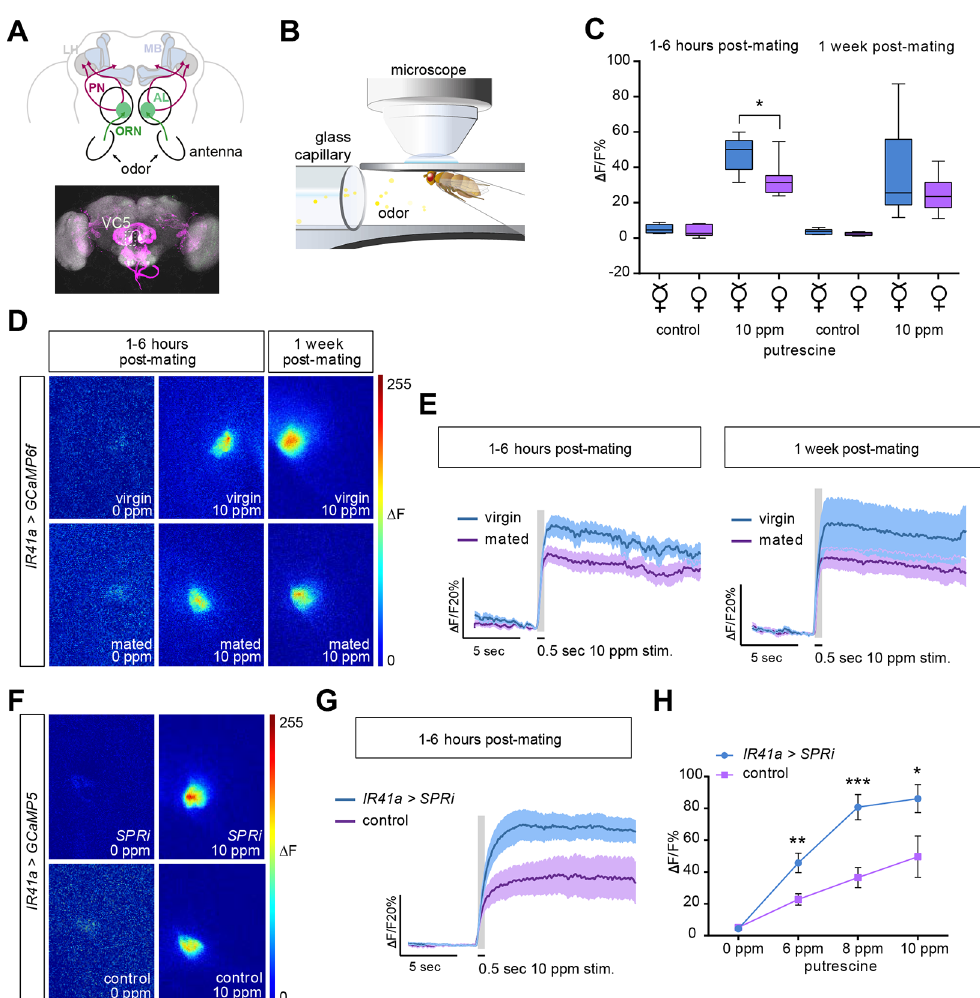
Fig 4. SPR decreases sensitivity of olfactory neurons to polyamines after mating. (A) Schematic diagram of a fly brain and its antennal appendages with olfactory sensory neurons (OSNs). OSNs project into the antennal lobe (AL), where they innervate a specific glomerulus (green). Projection neurons (PN) send the information mainly to two higher brain centers, the mushroom body (MB) and the lateral horn (LH) (top). Illustrative confocal image stack showing the IR41a and IR76b OSN innervation in the AL (bottom). VC5 is the glomerulus innervated by the polyamine-responding IR41a/IR76b sensory neurons. (B) Illustration of the in vivo calcium imaging setup. (C – E) In vivo calcium imaging of IR41-Gal4;UAS-GCaMP6f flies stimulated with water and 10 ppm putrescine, respectively. Mated females ’ OSN axon terminals show a significant reduction in their sensitivity to putrescine at 1 – 6 h post-mating. (C) Quantification of peak Δ F responses (in % Δ F/F) in virgin and mated females. Boxes show median and upper/lower quartiles, and whiskers show minimum/maximum values. * p < 0.05, unpaired t test ( n = 8). (D) Representative pseudo-color images showing the response to water and 10 ppm putrescine in virgin and mated flies at 1 – 6 h and 1 wk post-mating. (E) Average response trace (in % Δ F/F) of the VC5 glomerulus peak response at 1 – 6 h and 1 wk post-mating compared to traces from virgin females. The dark colored line in the middle presents the average value and the light shade presents the SEM. (F – H) In vivo calcium imaging of test ( IR41a-Gal4 , UAS-SPRi;UAS-GCaMP5 ) and control ( IR41a-Gal4;UAS-GCaMP5) mated female flies. OSN axon terminals of IR41a > SPRi females show significantly enhanced responses to putrescine compared to control females. (F) Representative pseudo-color images showing the response to water and 10 ppm putrescine in IR41a > SPRi and control females, respectively. (G) Average response trace of the VC5 glomerulus in IR41a > SPRi and control females at 1 – 6 h post-mating for 10 ppm putrescine. (E,G) The gray column represents the 0.5 s stimulation period. Dark colored line is the average response and the light shade is the SEM. (H) Quantification of peak Δ F responses (in % Δ F/F) in IR41a > SPRi and control females for 0 ppm, 6 ppm, 8 ppm, and 10 ppm putrescine, respectively ( n = 7 ± SEM). All p -values were calculated using an unpaired t test ( * p (cid:1) 0.05, ** p (cid:1) 0.01, *** p (cid:1)